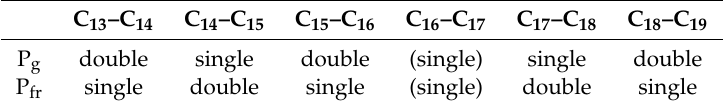
Table 2. Predicted C-C bond character trends in the conjugated system of rings C and D of PCB in P g and P fr state based on Table 1 and a threshold of 144 pm. There is no reliable prediction possible for bond C 16 –C 17